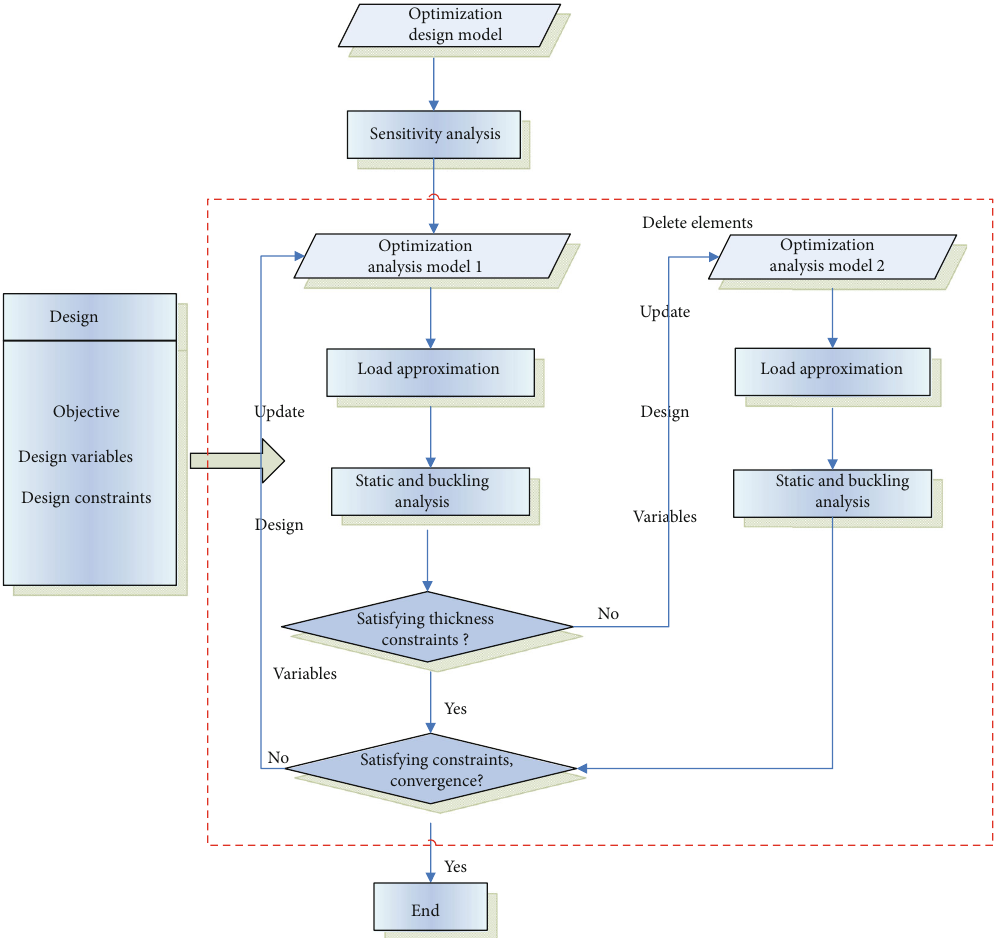
Figure 5: Flowchart of the wing optimization